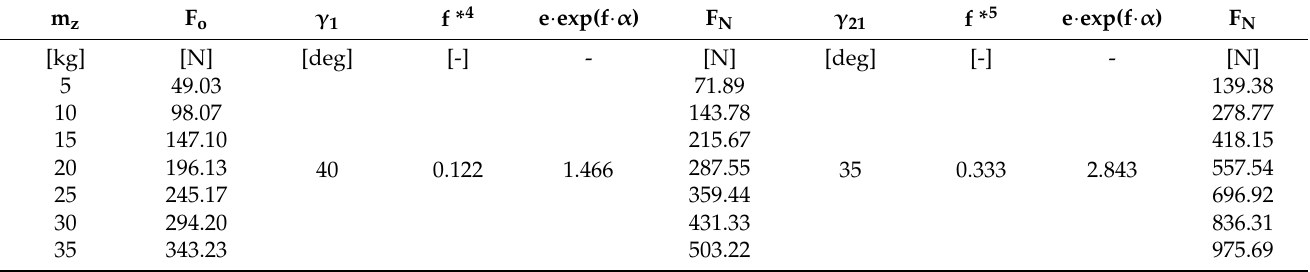
Table 7. Pulling forces in the sides of a cable running over a pulley groove for different groove